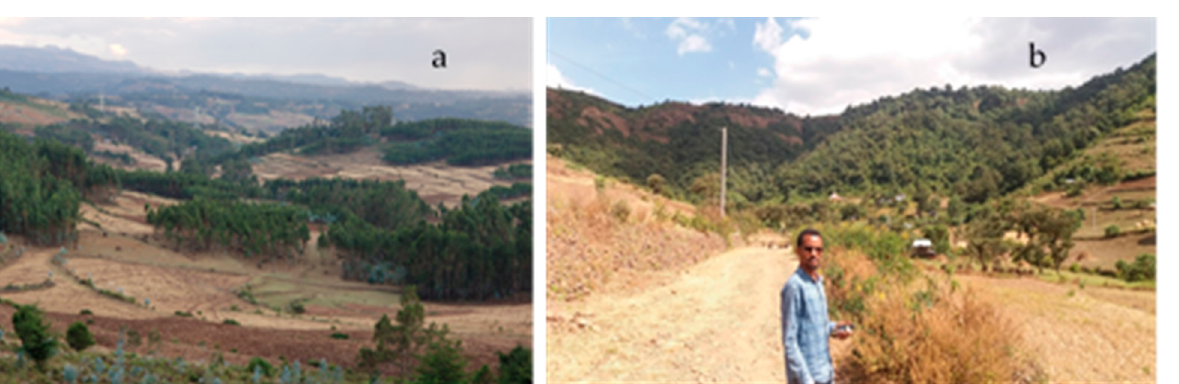
Table 2. Characteristics of identified land cover classes in the study